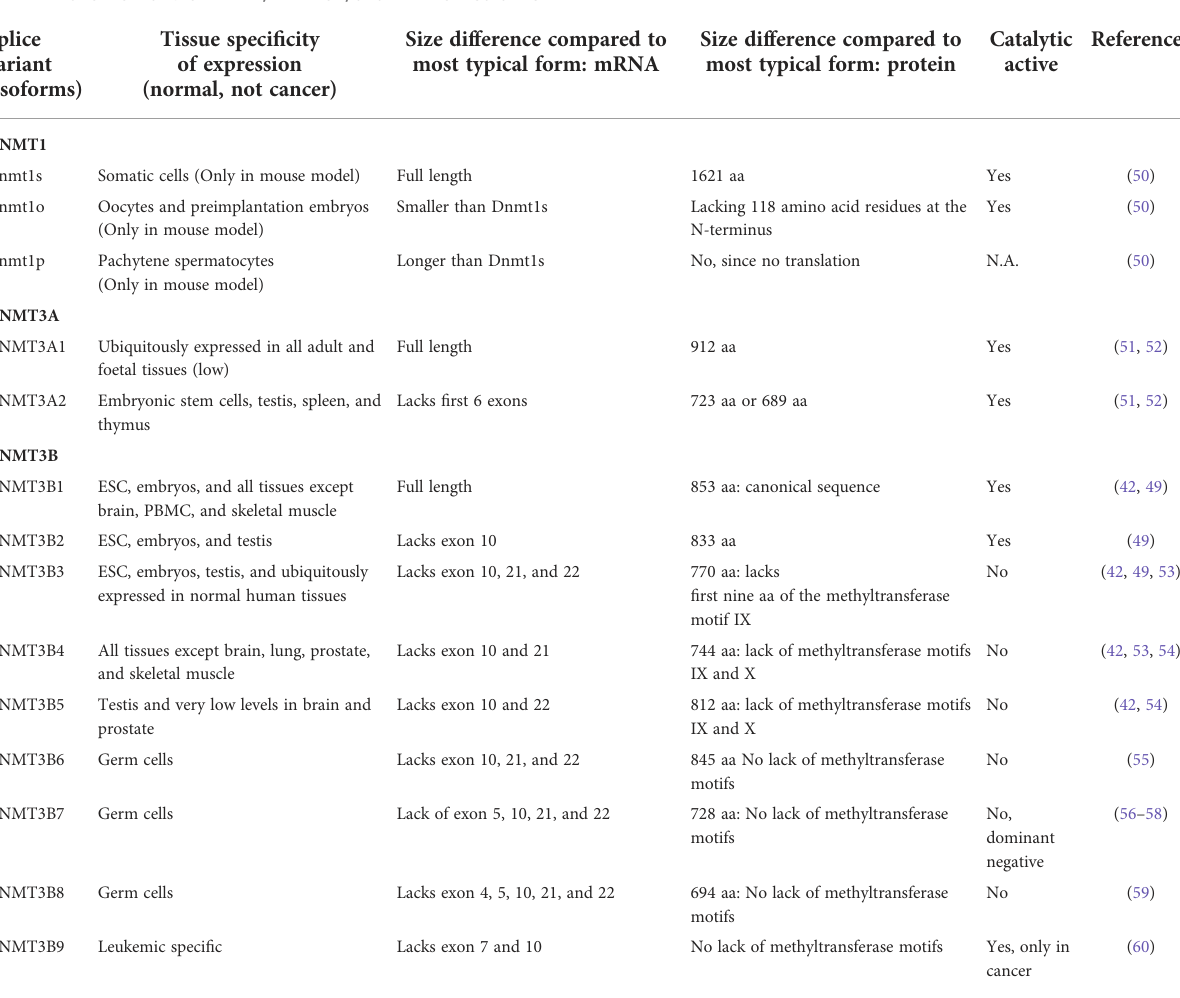
TABLE 1 Overview of the DNMT1, DNMT3A, and DNMT3B isoforms. Splice